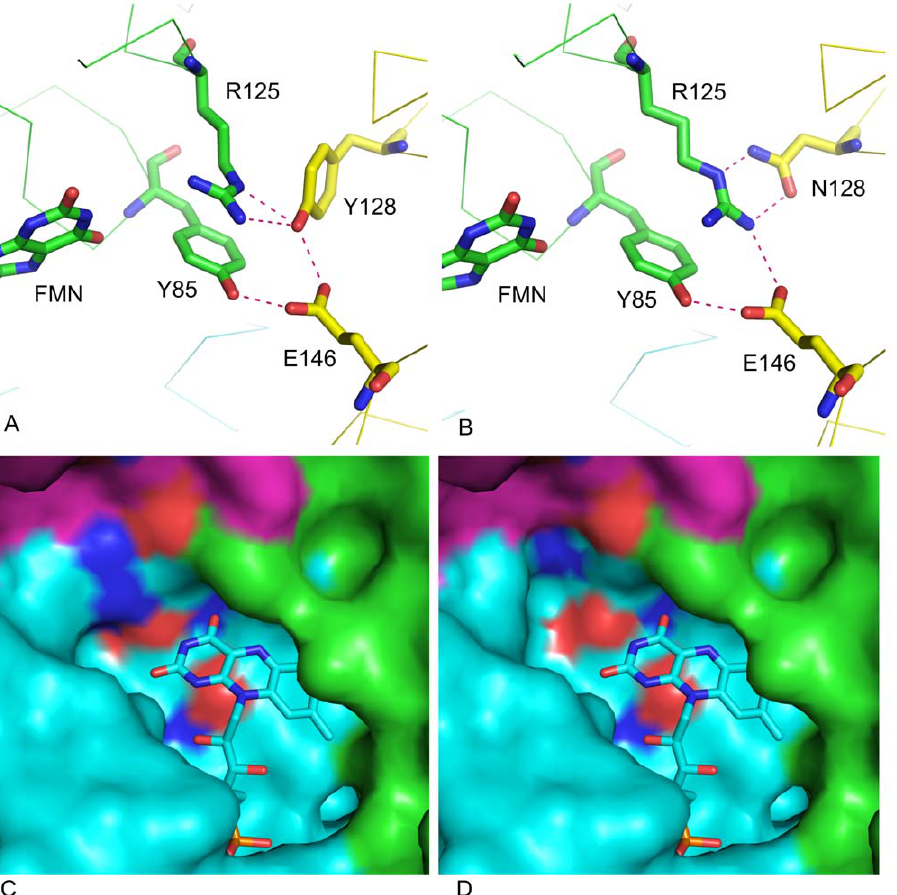
Figure 4. Diagramatic representation of the possible ways by which Tyr128Asn substitution in ChrR may increase chromate reductase activity. Fig. 4a and 4b show changes in hydrogen bonding between the dimers, and the surface diagrams (4c and 4d) show changes in the cavity around FMN. Both diagrams show the same location but for clarity the surface diagram view is rotated 90 u on Z-axis and 45 u on X-axis of the bonding diagram; Arg125 location is maintained at the top for direct comparison of the two views. See text for details. doi:10.1371/journal.pone.0036017.g004 PLoS ONE |